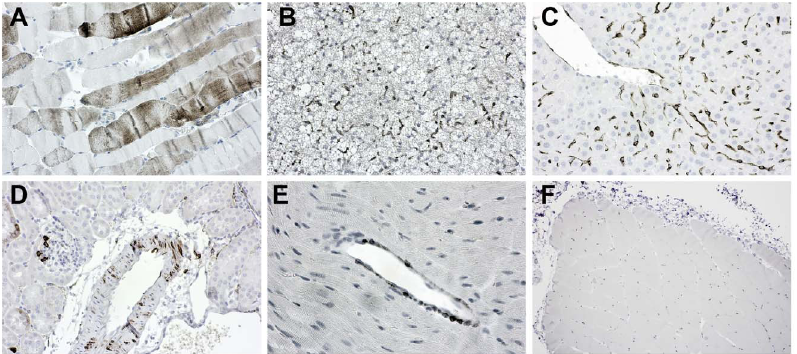
Figure 5. Mouse transgenic model of Cthrc1 overexpression. Cthrc1 protein was assessed by immunohistochemistry in bi-transgenic Tg(CagGfp-hCthrc1) Vli / Tg(Pdgfrb-Cre) 35Vli mice. (A) Skeletal muscle, (B) capillaries in brown adipose tissue, (C) hepatic endothelium, (D) vascular smooth muscle in the kidney, and (E) mural cells of venules expressed Cthrc1. (F) As a control, no Cthrc1 expression is detectable in wildtype skeletal muscle. Cthrc1 immunoreactivity in brown with hematoxylin counterstain. Original magnification 200x (A-D), 400x (E), and 100x